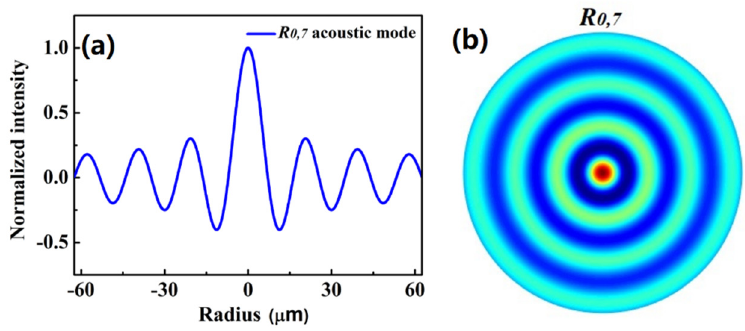
Figure 5. ( a ) The density vibration profile and ( b ) spatial distribution of R 0,7 mode. We also experimentally measure the FBSS of the MSI 2-LP-mode fiber using a Sagnac loop, and the measured results are shown in Figure 6. It can be found that the resonance frequencies of R 0,m modes in the MSI 2-LP-mode fiber are equally spaced with a spacing of 47.03 MHz. By solving Equations (6), (7) and (9), the calculated resonance frequency of R 0,7 mode is 322.7 MHz, which agrees well with the measured result of 319.7 MHz in Figure 6.